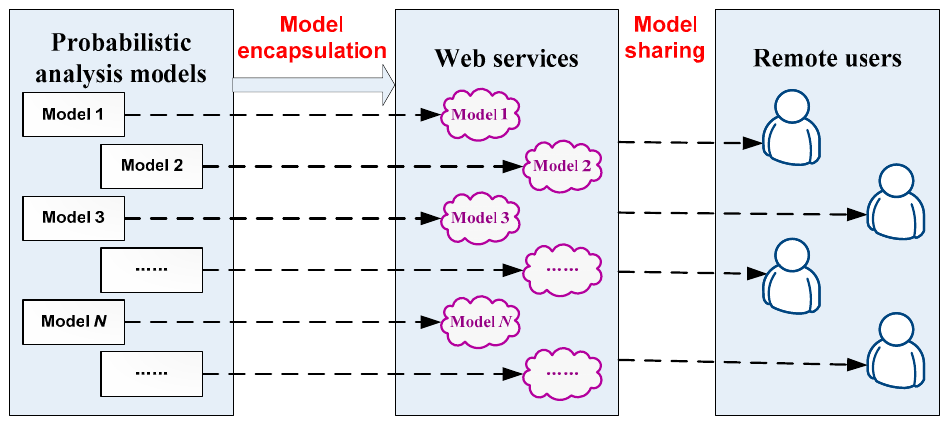
Figure 5. Schematic diagram of model encapsulation and sharing.